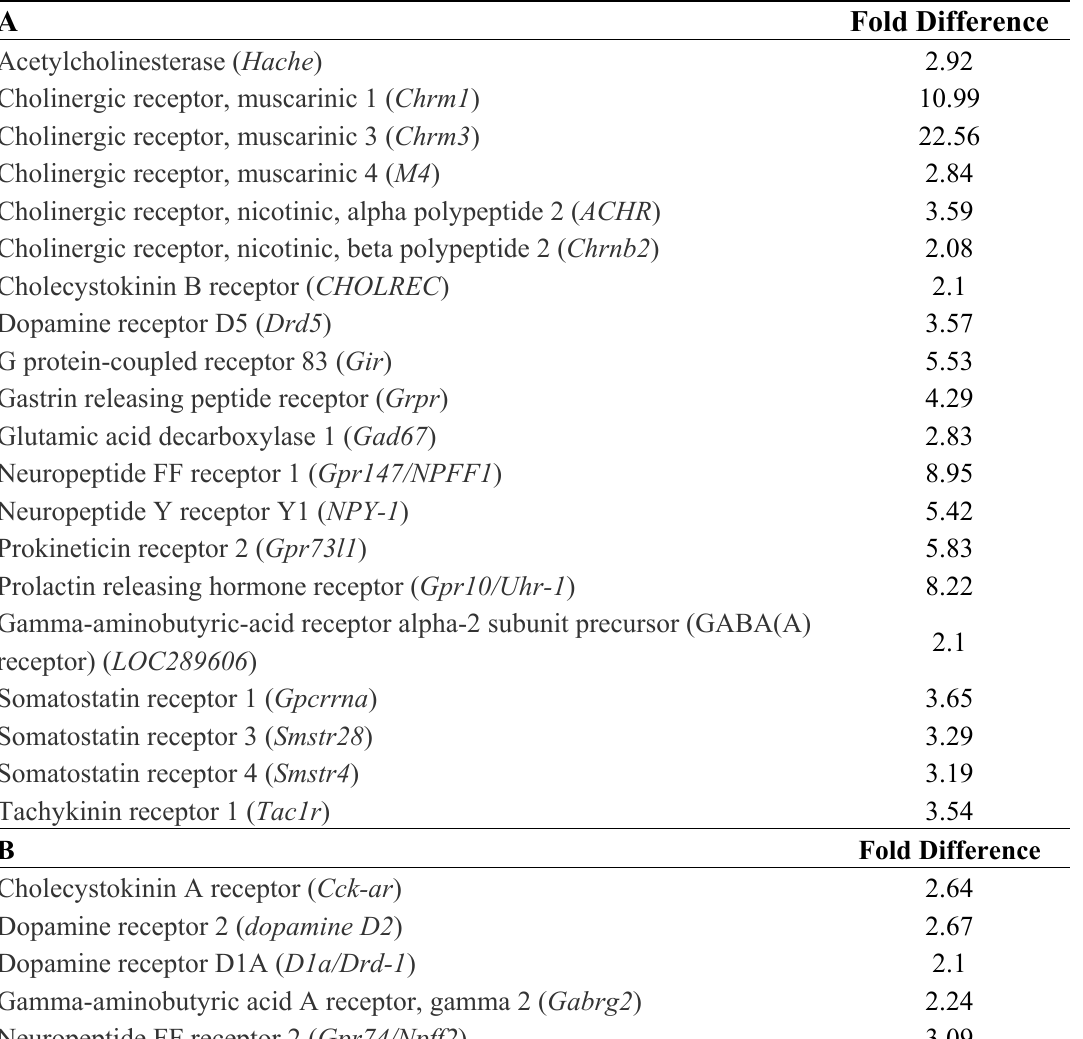
Table 1. ( A ) Genes that Decrease at the End of Pregnancy; ( B ) genes that Increase at the End of